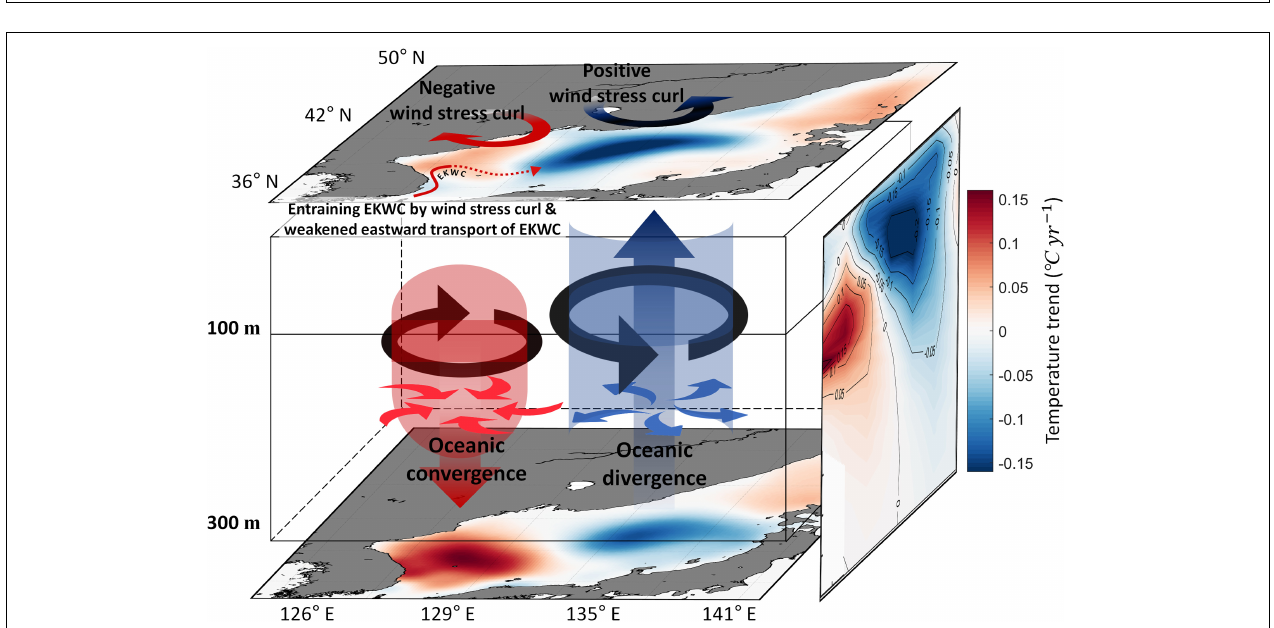
FIGURE 8 | Conceptual schematics representing the wind stress curl-driven convergence (downwelling) and divergence (upwelling) processes in the Regions A and B during the SWS period in the western and eastern ES, respectively. The red line and the red dotted arrow indicate bifurcating poleward entrained EKWC and weakened eastward transport of EKWC, respectively, due to strengthened negative wind stress curl during the SWS period.